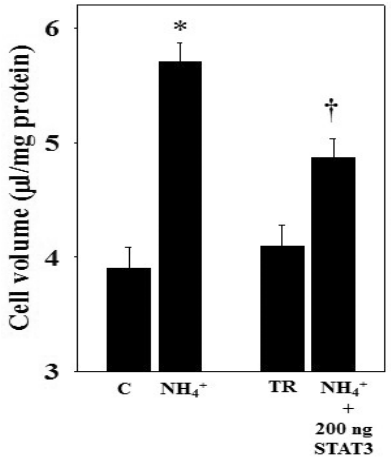
Figure 7. Effect of STAT3 overexpression on the ammonia-induced astrocyte swelling. STAT3-overexpressing cells showed less swelling following ammonia treatment (24 h), as compared to non-transfected cells (WT cells). Data were subjected to ANOVA followed by Tukey‘s post hoc comparison test ( n = 3). * p < 0.05 vs. control and TR; † p < 0.05 vs. TR and NH 4+ . Error bars, mean ± S.E. C, control; TR, transfection reagent.